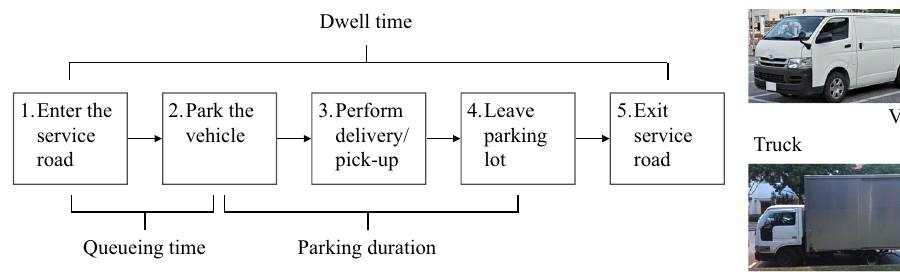
Fig. 1 Baseline process flow of a goods vehicle delivering or picking up goods. Right of figure: example of van (height < 2.5 m) and truck (height > 2.5